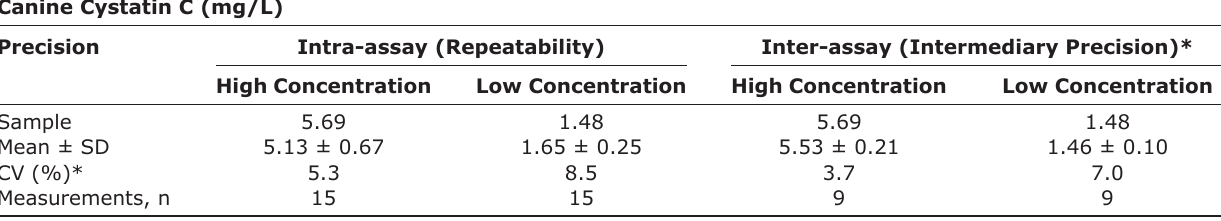
Table-1: Means and standard deviations of sCy in canine samples with high and low concentrations used to evaluate the precision of the intra-assay and inter-assay. Canine Cystatin C (mg/L)